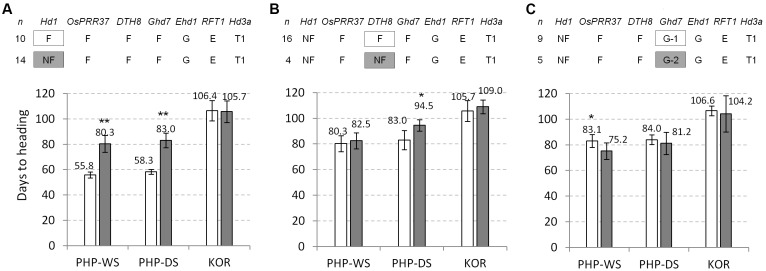
Genetic effects of the major flowering genes on flowering time in three different field conditions. Allele types of each flowering gene and the number of samples are presented on the top panel. (A) Genetic effect of Hd1. (B) Genetic effect of DTH8. (C) Comparison of the genetic effects between Ghd7-1 (G-1) and Ghd7-2 (G-2) alleles. A significant difference between two groups was calculated based on Student’s t-test (∗α = 0.05 and ∗∗α = 0.01). PHP, Philippines; KOR, Korea. DS, dry season; WS, wet season.